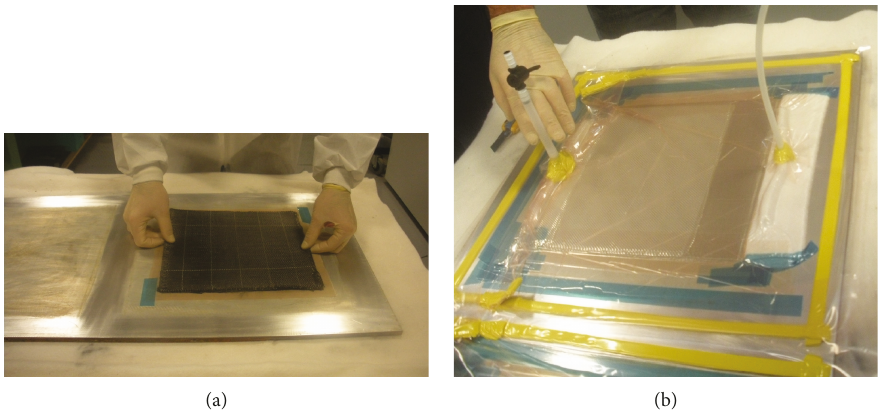
Figure 2: (a) Placing of the dry preform and (b) vacuum bag.